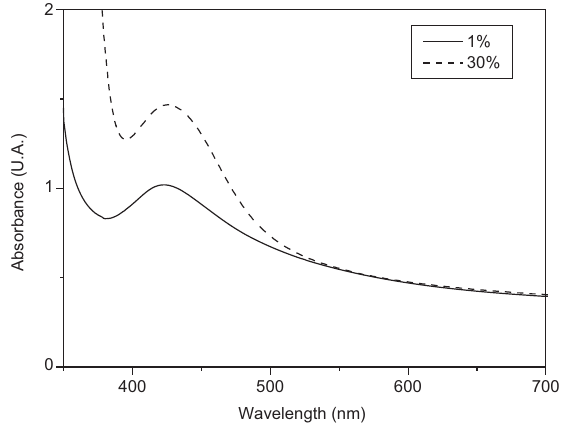
Figure 4 Optical spectra of two Ag/PS fi lms obtained by thermally annealing [Ag(hfac)(COD)]/polystyrene fi lms containing a different amount of silver